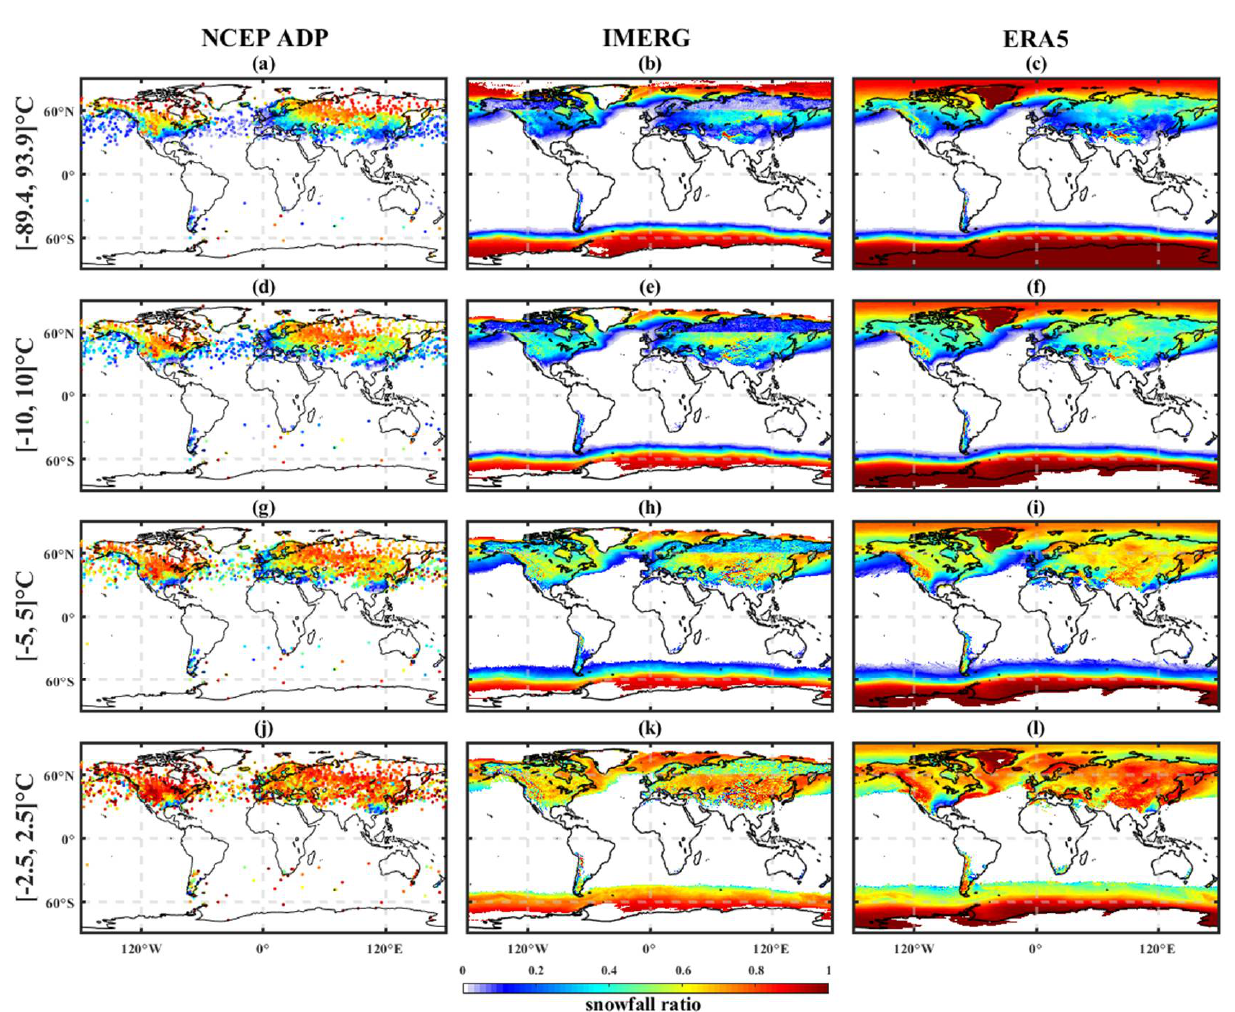
Figure 7. Snowfall ratio under different air temperature of NCEP ADP ( a , d , g , j ), IMERG ( b , e , h , k ), and ERA5 ( c , f , i , l ). The air temperature range (−89.4 ~ 93.9 °C) of NCEP ADP refers to Kubecka [49] and Gleason [50].